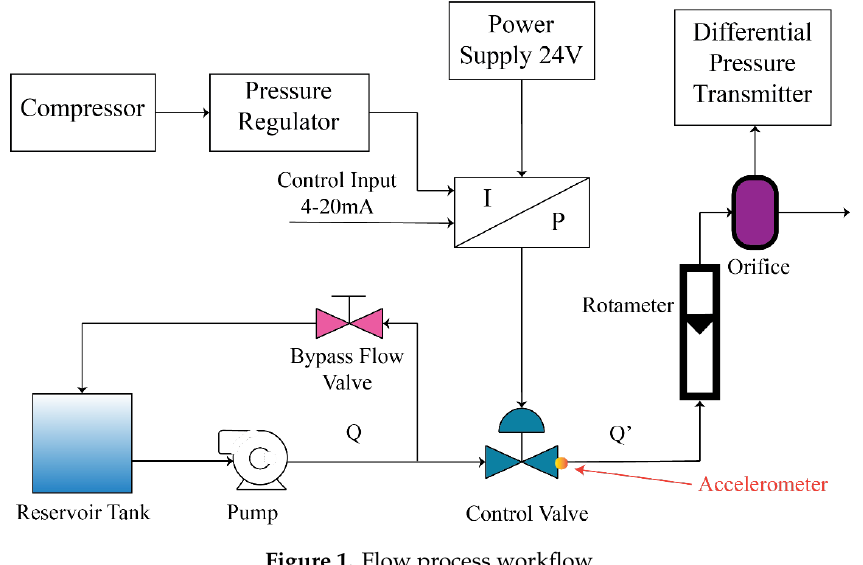
Figure 1. Flow process workflow .